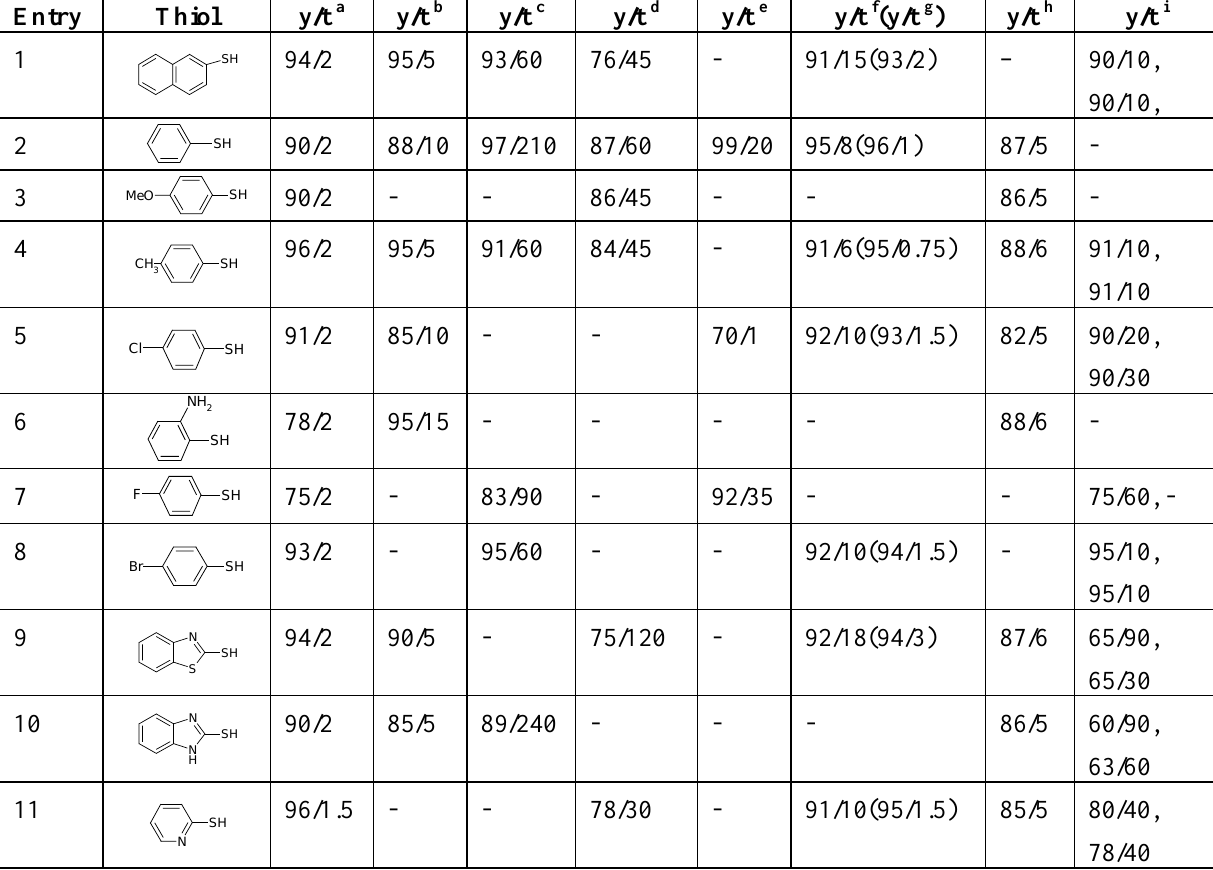
Table 2. Comparison of yield%/time (min.) (y/t) for the oxidation of some thiols by present method with those reported in the